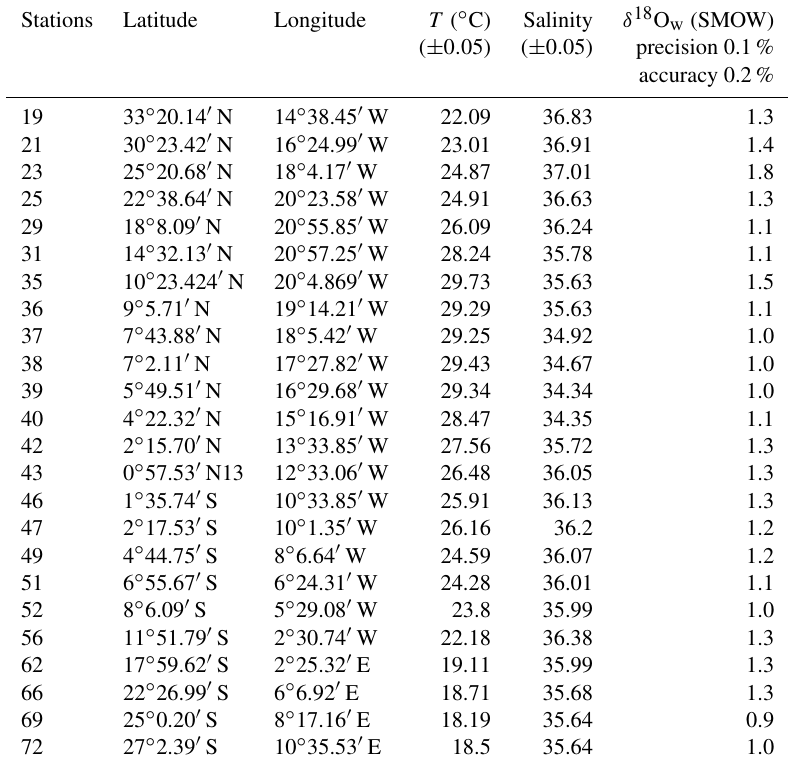
Table 4. Temperature, salinity and δ 18 O w of the stations used to determine the salinity– δ 18 O w relationship (Eq.